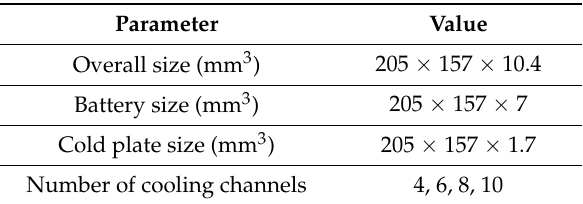
Figure 1. Numerical model for the 20 Ah lithium-ion pouch cell with cold plates along both surfaces ( a ) Geometry ( b ) Schematic ( c ) Meshing-full domain ( b ) Meshing-section. Table 1. Geometry details.